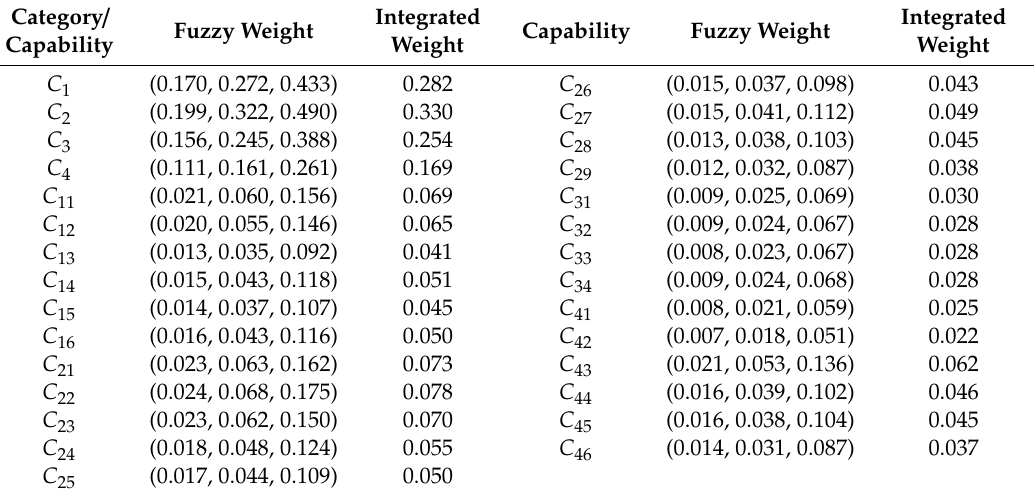
Table 3. The fuzzy weight and integrated weight of